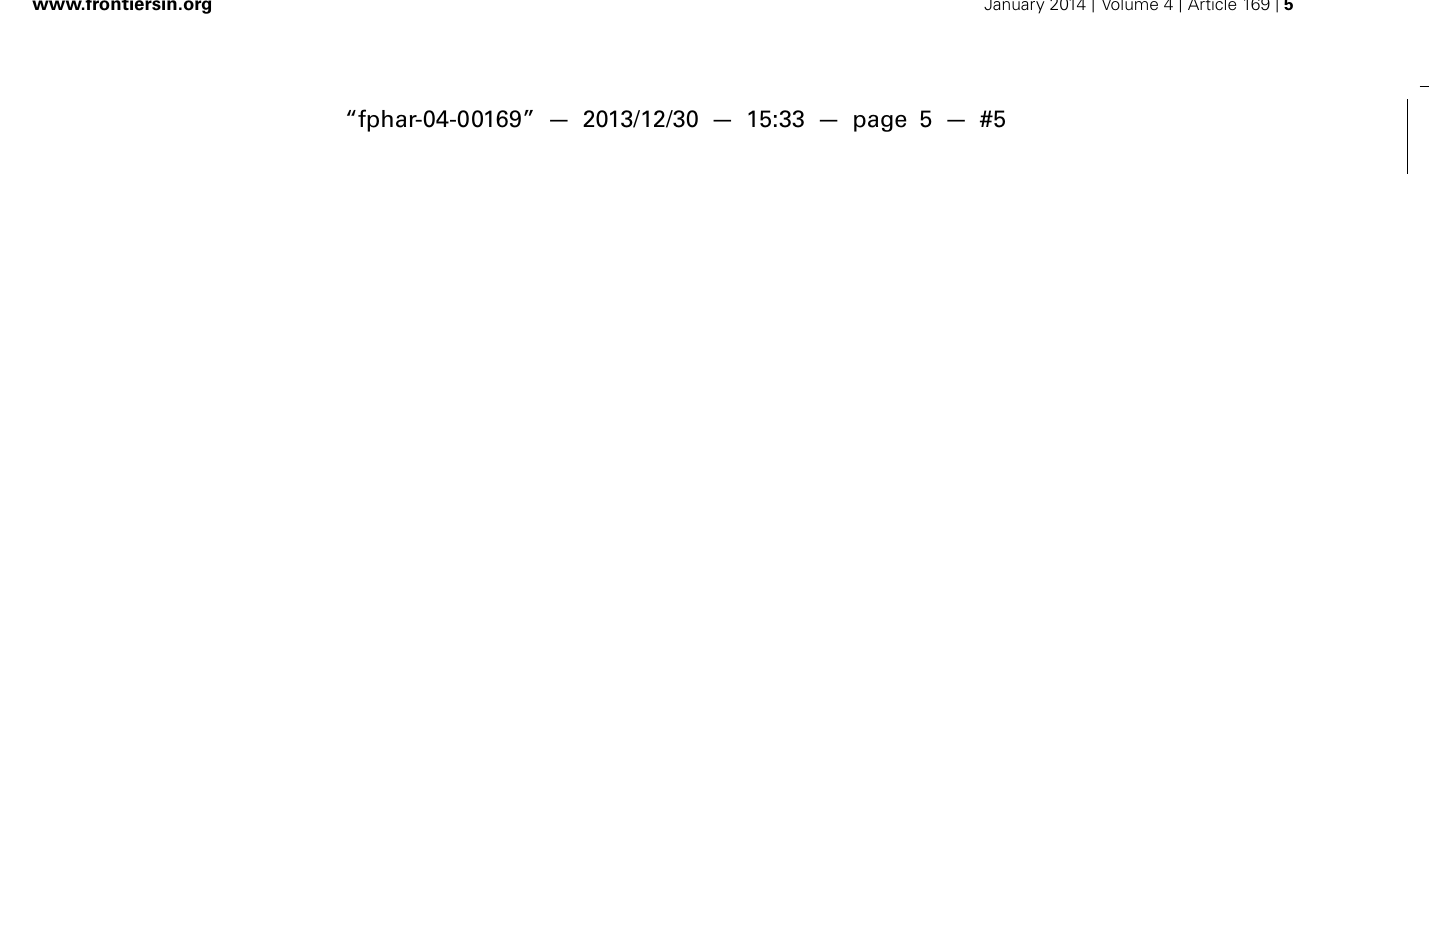
This protein has been found to be associated with the cytoso- lic regions of a variety of GPCRs (Sánchez-Blázquez et al.,